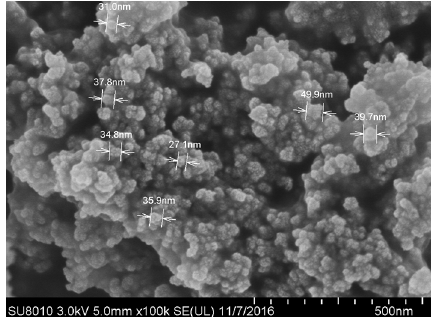
Figure 2. Morphology of NPs [43].